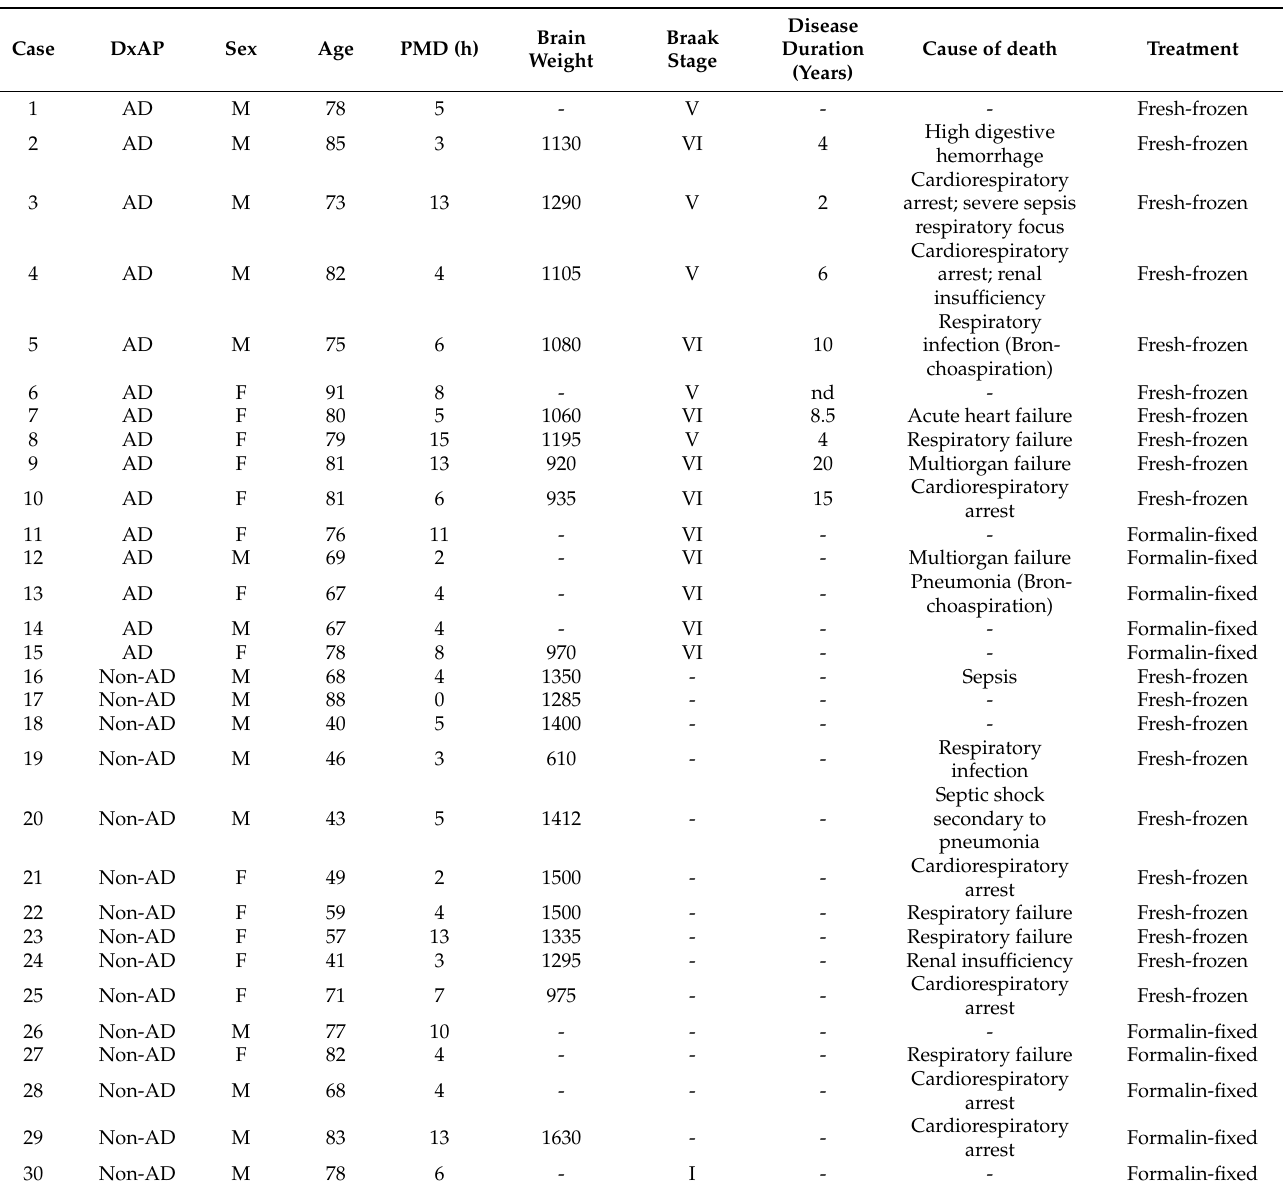
Table 2. Human samples of hippocampus used in this study. DxAP (anatomopathological diagnostic); PMD (postmortem